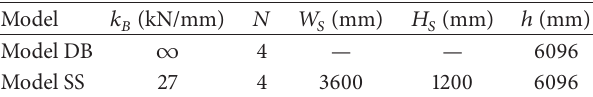
Table 4: Analysis